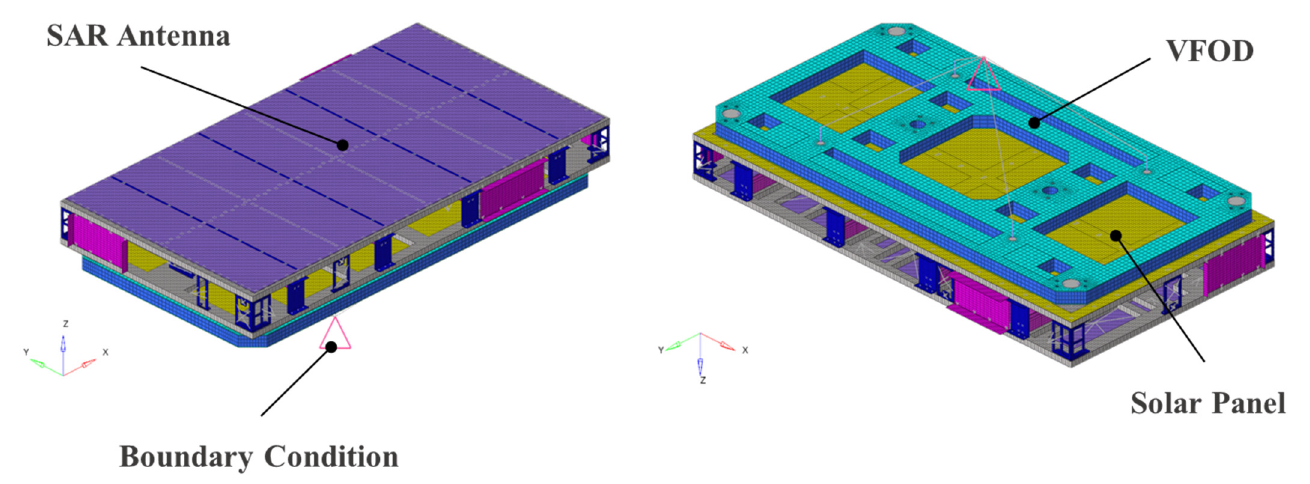
Figure 10. Finite-element model (FEM) of the S-STEP system.